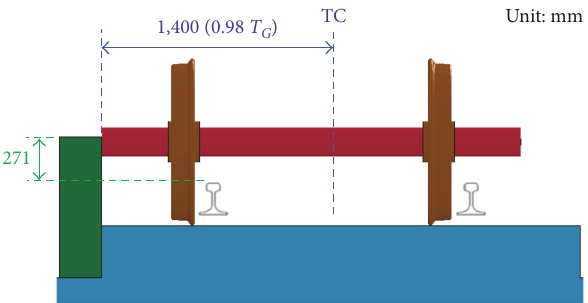
Figure 8: Overview of distance effect 1.